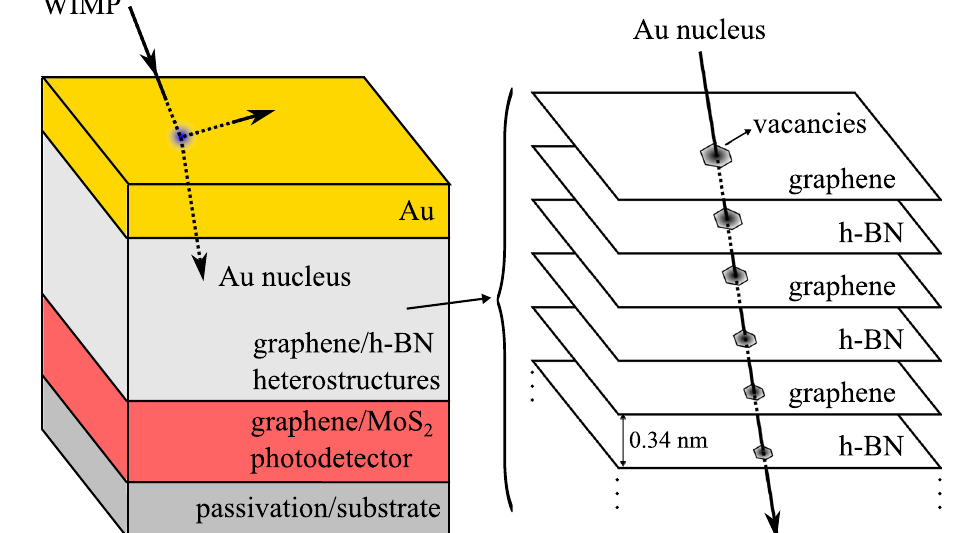
Fig. 1 (left) Schematic illustration of a single “cell” of the proposed detector (not to scale in the vertical direction). A WIMP scatters elas- tically off a Au nucleus in the gold film, and the recoiling nucleus tra- versesthegraphene/h-BNheterostructure.(right)Schematicclose-upof the graphene/h-BN heterostructure and the primary vacancies (shaded